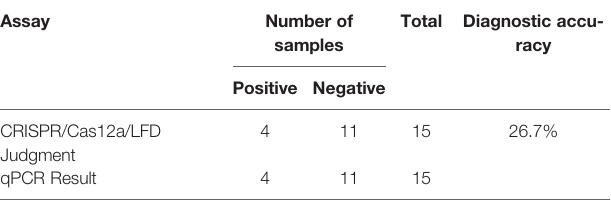
TABLE 2 | Comparison of qPCR and CRISPR/Cas12a/LFD results for clinical